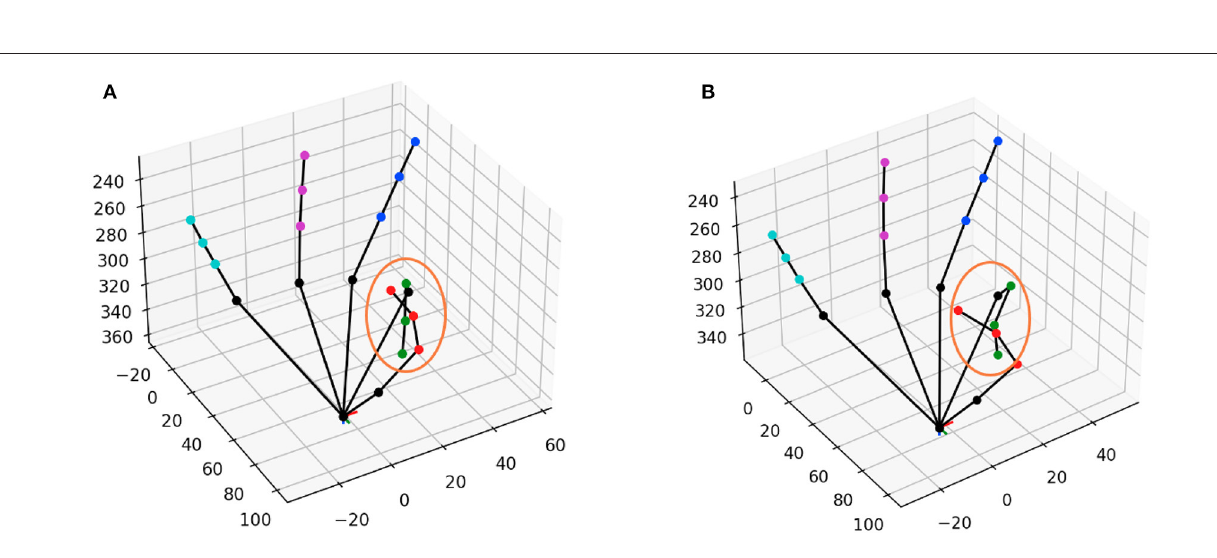
Frontiers in Artificial Intelligence | www.frontiersin.org 7 February 2022 | Volume 5 | Article